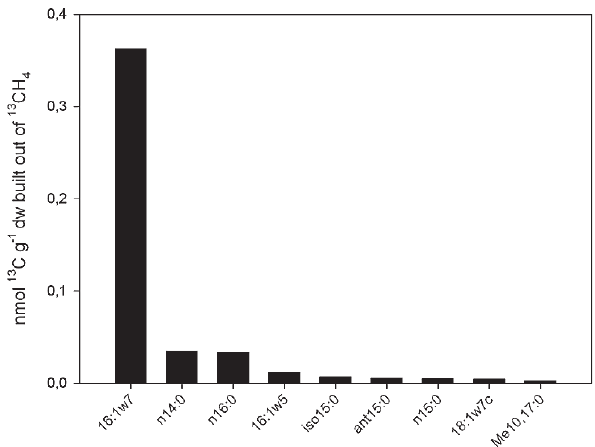
Fig. 4. Ranking of the absolute carbon incorporation from labelled methane into PLFAs of SI CH 4